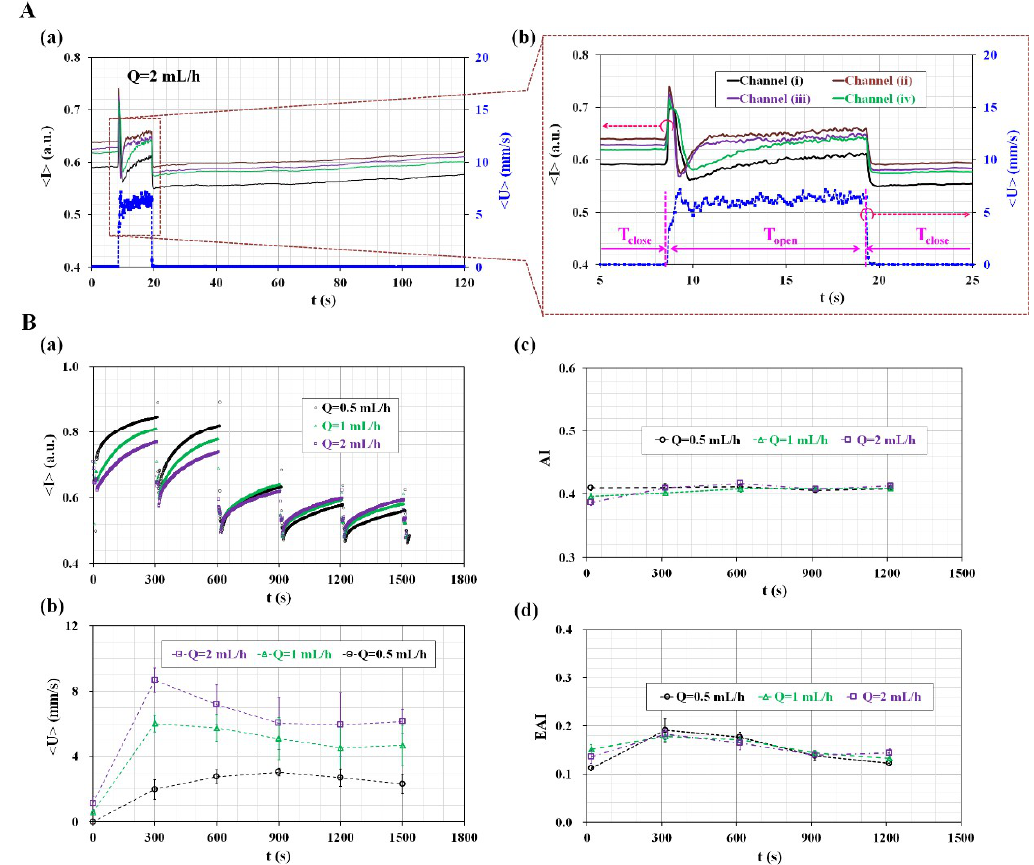
Figure 4. The quantitative evaluation of the effects of vital two factors including pinch-valve operation and syringe pump flow-rate on the measurement of RBC aggregation and ESR. ( A ) Dynamic characterization of image intensity (< I >) and blood velocity (< U >) based on operation of the pinch valve (open, close). To evaluate transient response with a high resolution, < I > and < U > were obtained at intervals of 0.1 s. Hematocrit of blood was adjusted to 30% by adding normal RBCs into the plasma solution. At the constant flow rate of 2 mL/h with syringe pump, temporal variations of < I > and < U > were obtained for specific duration of ( A-a ) 120 s and ( A-b ) 25 s. As a result, blood flow was stopped immediately within 0.2 s after clamping a tube with a pinch (i.e., close). ( B ) The effect of syringe pump flow-rate ( Q ) on the measurement of RBC aggregation (i.e., AI) and ESR (i.e., EAI). Temporal variations of < I > and < U > were obtained by varying flow rate of syringe pump ( Q ) ( Q = 0.5, 1, and 2 mL/h). ( B-a ) Temporal variations of < I > with respect to blood flow rate. ( B-b ) Temporal variations of < U > with respect to syringe pump flow-rate. ( B-c ) Temporal variations of AI with respect to syringe pump flow-rate. ( B-d ) Temporal variations of EAI with respect to syringe pump flow-rate.